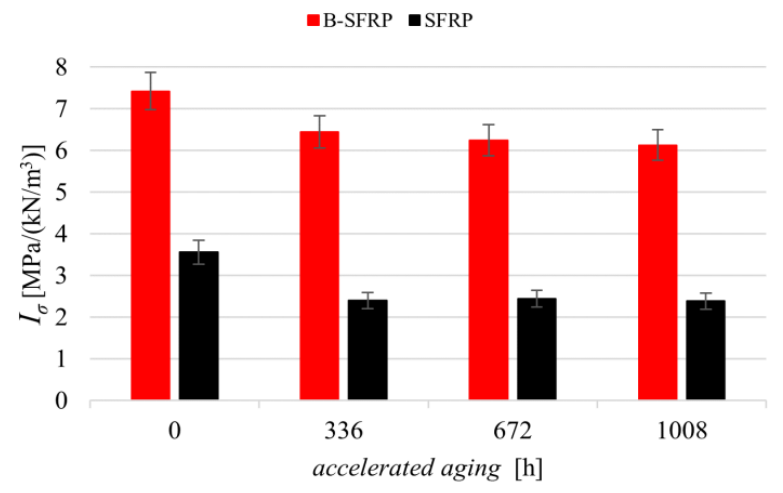
Figure 14. Specific compressive strength of SFRP and B-SFRP before and after progressive aging.